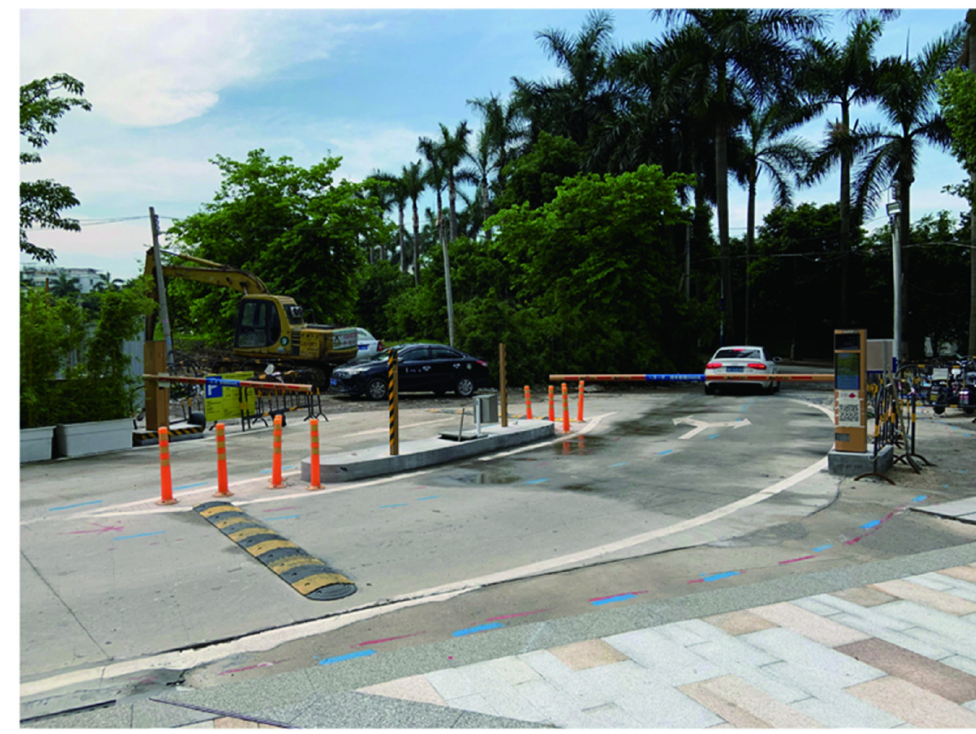
Figure 12. Current situation of cargo/vehicle entrances and exits of Nanpu